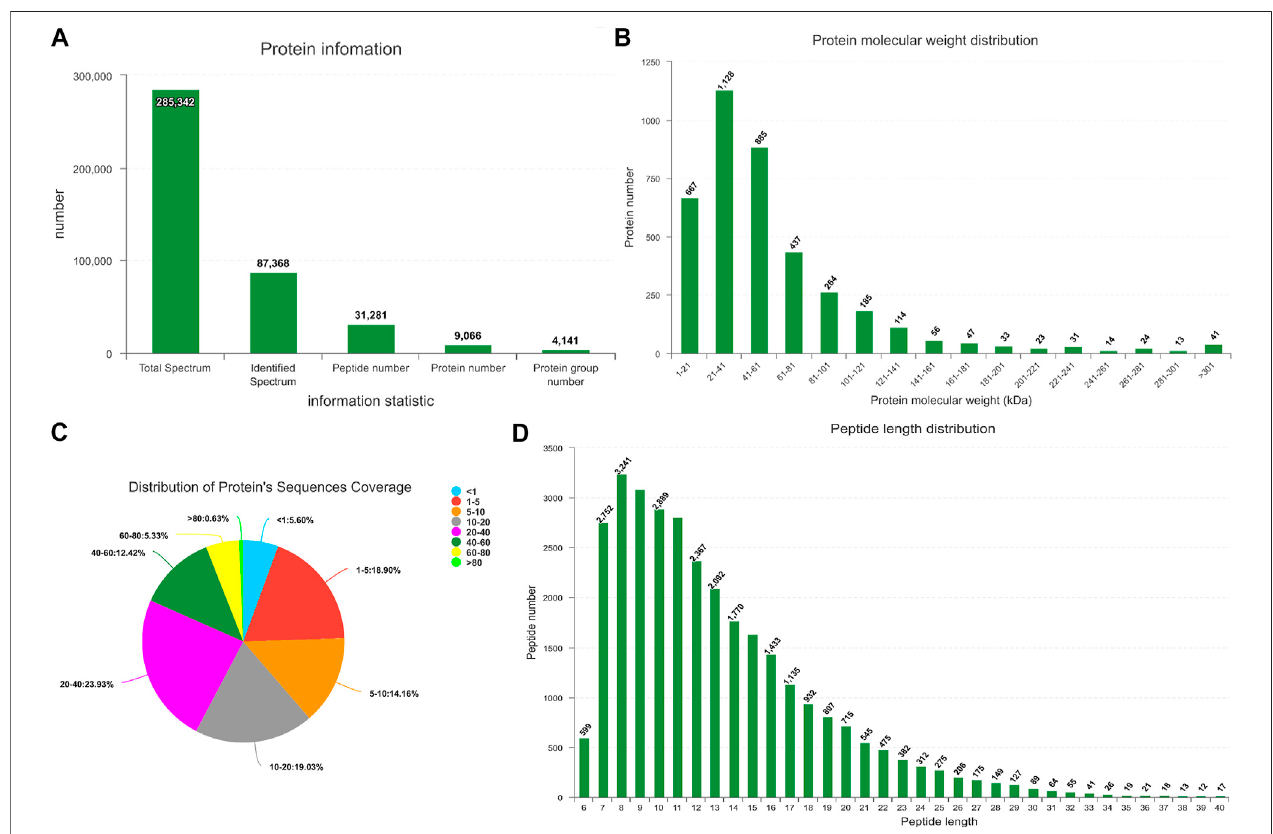
FIGURE 5 | Quality control of protein data validation. (A) Protein information. The x-axis in the fi gure represents the identi fi ed protein information, from left to right: the totalnumberofsecondaryspectra,thenumberofmatchedspectra,thenumberofidenti fi edpeptides,thenumberofidenti fi edproteins,andthenumberofidenti fi edprotein groups. (B) Protein mass distribution of all identi fi ed proteins. (C) Distribution of protein ’ s sequences coverage. (D) Protein length distribution of all identi fi ed